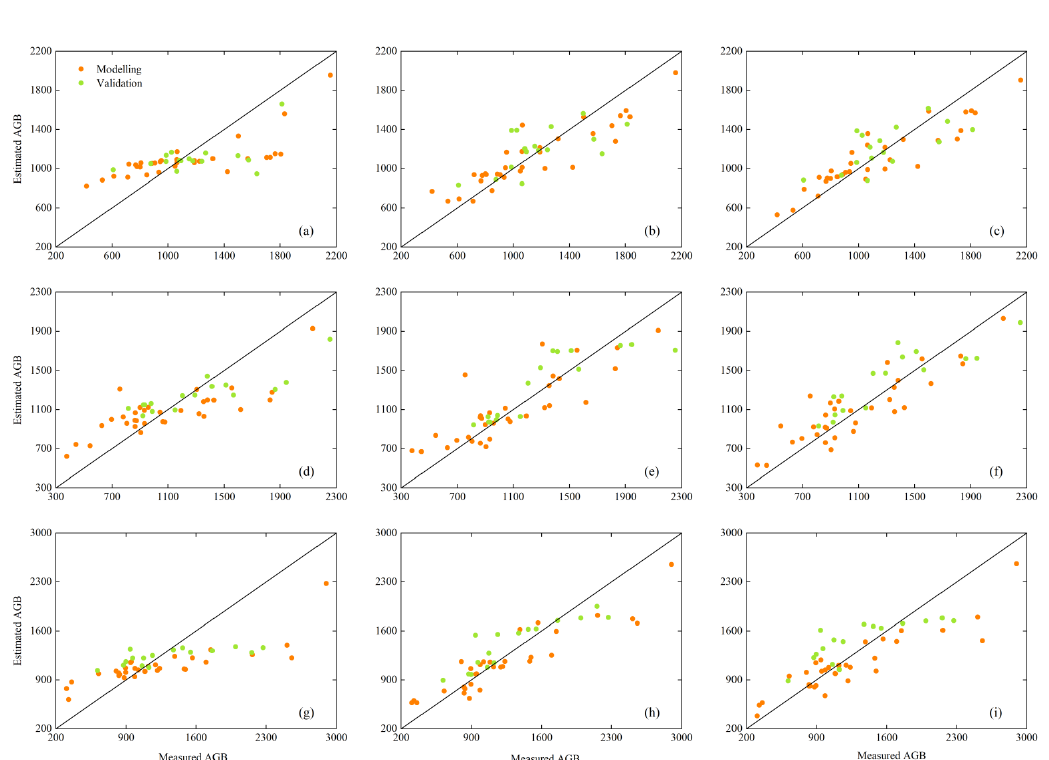
Figure 6. Scatter plots of measured versus estimated potato AGB (kg/hm 2 ) for modeling and validation datasets and for different growth stages. SVM, RF, and GPR methods are used with VIs as input. ( a – c ) The relationship between measured and estimated potato AGB for the tuber-formation stage. Estimates were made by SVM, RF, and GPR, respectively. ( d – f ) Same as panels ( a – c ) but for the tuber-growth stage. ( g – i ) Same as panels ( a – c ) but for the starch-storage